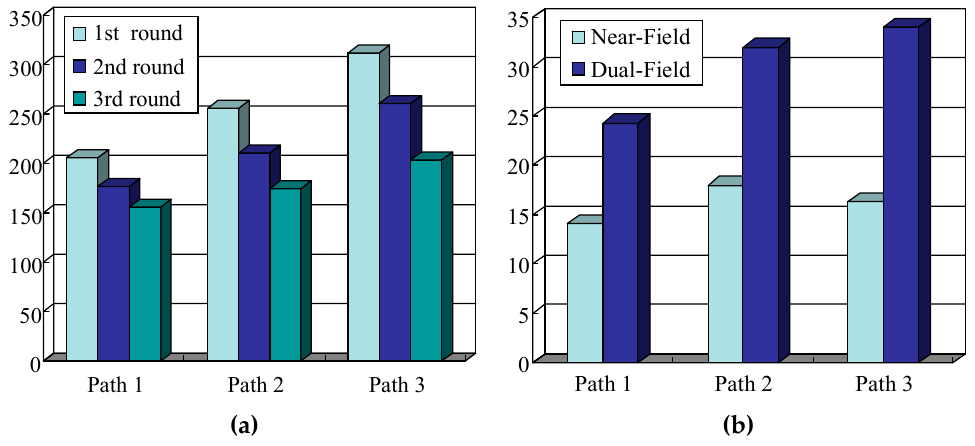
Figure 27. ( a ) Traveling time on each test path; ( b ) Increased efficiency for each path.